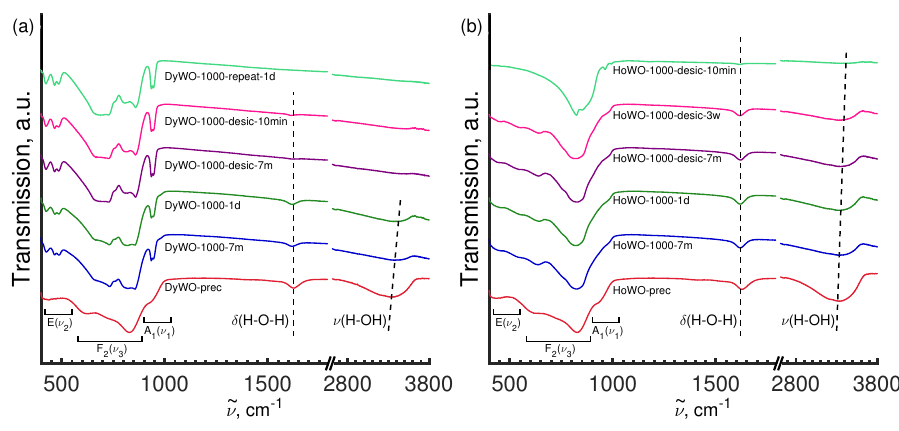
Figure 9. FT-IR spectra of Dy 2 (WO 4 ) 3 ( a ) and Ho 2 (WO 4 ) 3 ( b ) powders prepared under different conditions. The FT-IR spectrum of the as prepared and quenched in a desiccator HoWO-1000-desic sample manifests absorption bands at 823 cm − 1 , 850 cm − 1 (both asymmetric stretching vibration ν 3 [43]), 962 cm − 1 and 993 cm − 1 (both symmetric stretching vibration ν 1